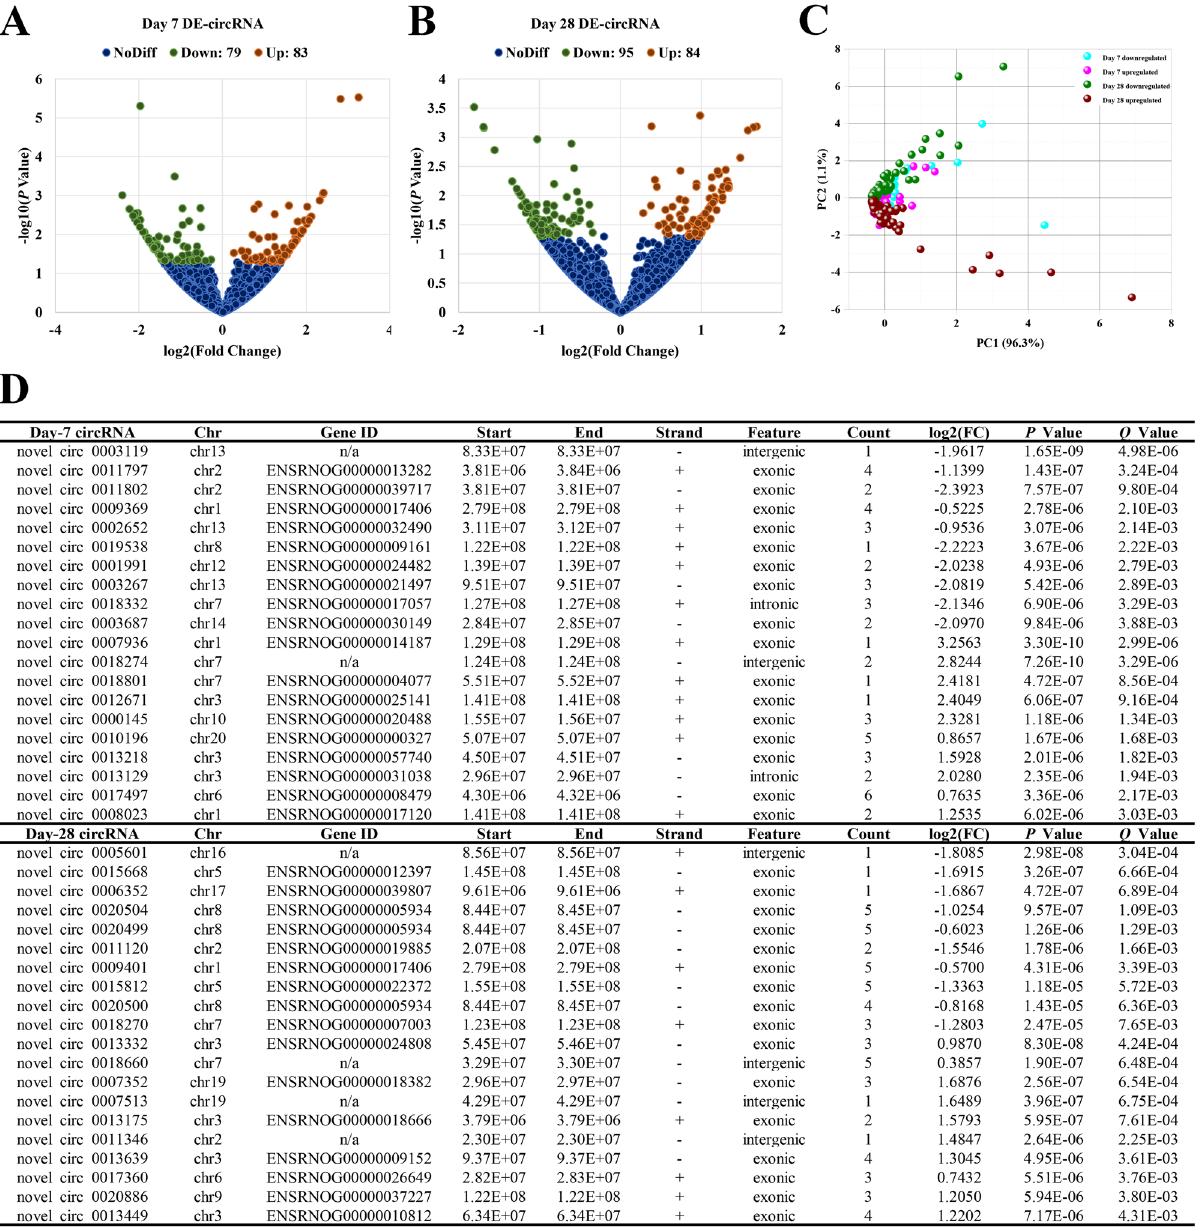
upregulated circRNAs in ICH compared with Sham on day 7 (Fig. 1A), and 95 statistically downregulated cir- cRNAs and 84 statistically upregulated circRNAs in ICH compared with Sham on day 28 (Fig. 1B). In addition, the variance (97.4%) explained by the principal components chosen distinguished day-7 samples from day-28 ones (Fig. 1C). The detail of these differentially expressed circRNAs in individual samples and the feature of these circRNAs were summarized in Supplementary Table S2 and S3, respectively. The top 10 most significantly up- and downregulated circRNAs in each time point were shown in Fig. 1D. Of the 28,937 mRNAs detected in the